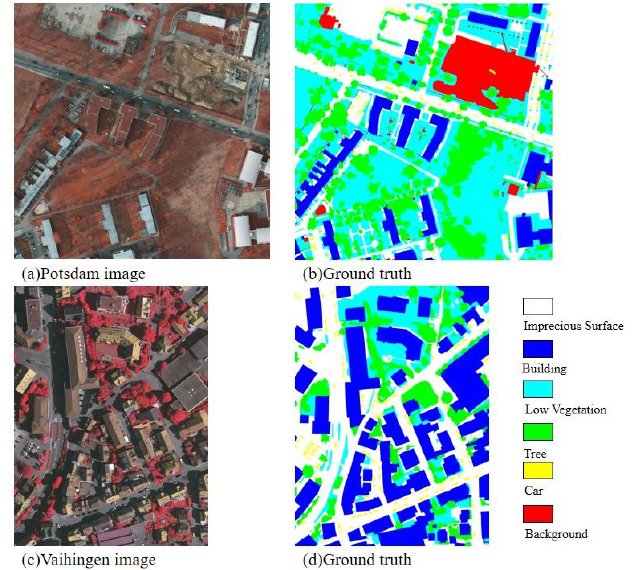
Figure 4. Images of the Potsdam and the Vaihingen dataset and their corresponding labels. Potsdam is a historic city in Germany, with large buildings and densely intertwined streets. The Potsdam dataset contains 38 images at a ground surface distance (GSD) of about 9 cm, including five channels of infrared, red, green, blue, and digital surface models (DSM) with a resolution of 6000 × 6000 pixels. For experiments, out of the available 38, we used 24 images for training and 14 images for testing. Note that we used ground truth with no eroded boundary labels in the experiments. On the other hand, Vaihingen is a village with small and scattered buildings. The Vaihingen dataset contains 3-band IRRG (infrared, red, and green) image data, corresponding DSM, and a normalized digital surface model (NDSM) data [41]. At a GSD of about 9 cm, there are 33 images of about 2500 ×